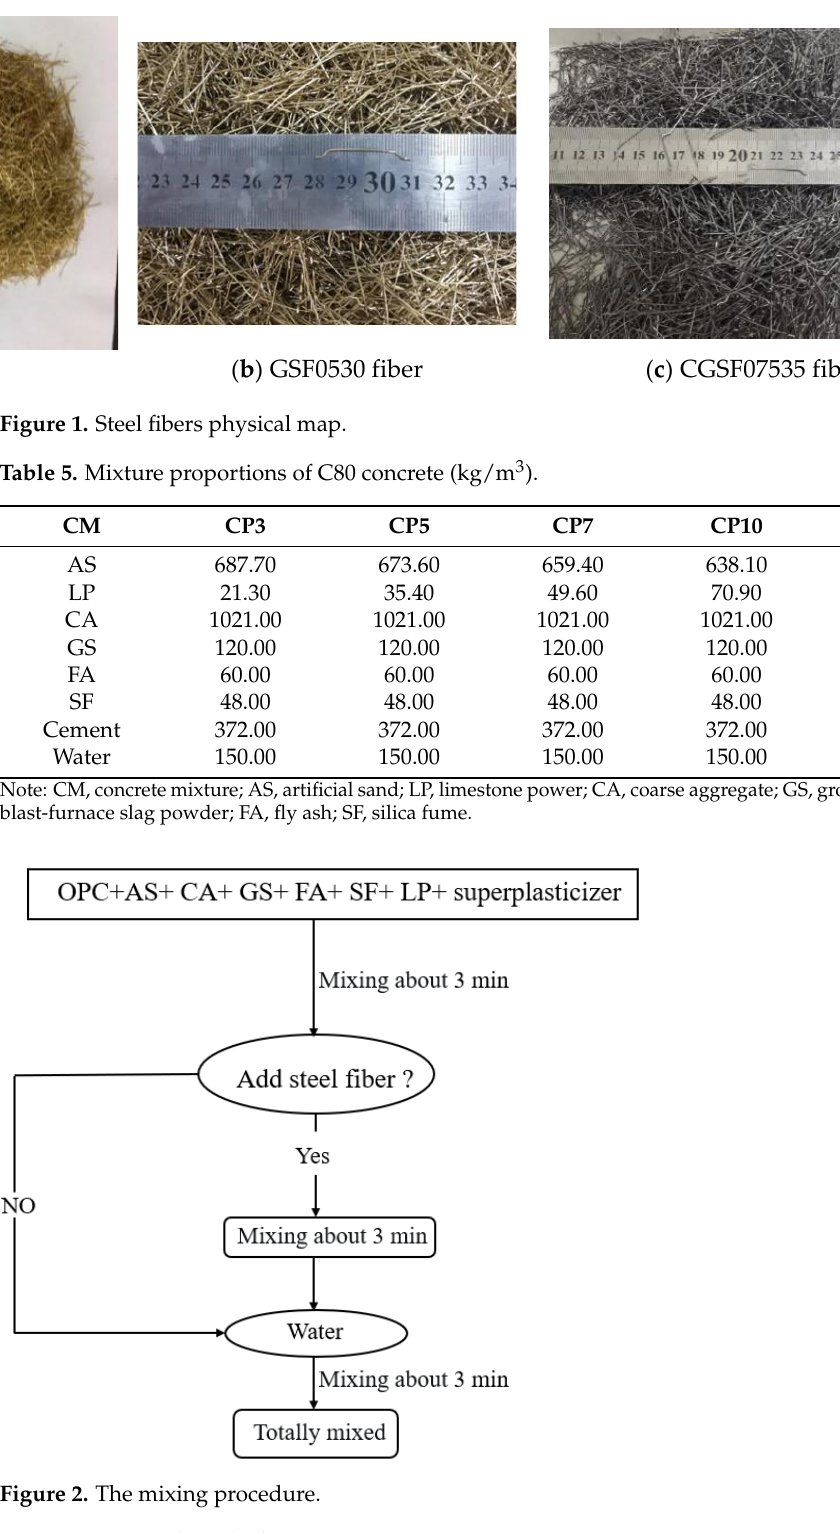
Figure 2. The mixing procedure.